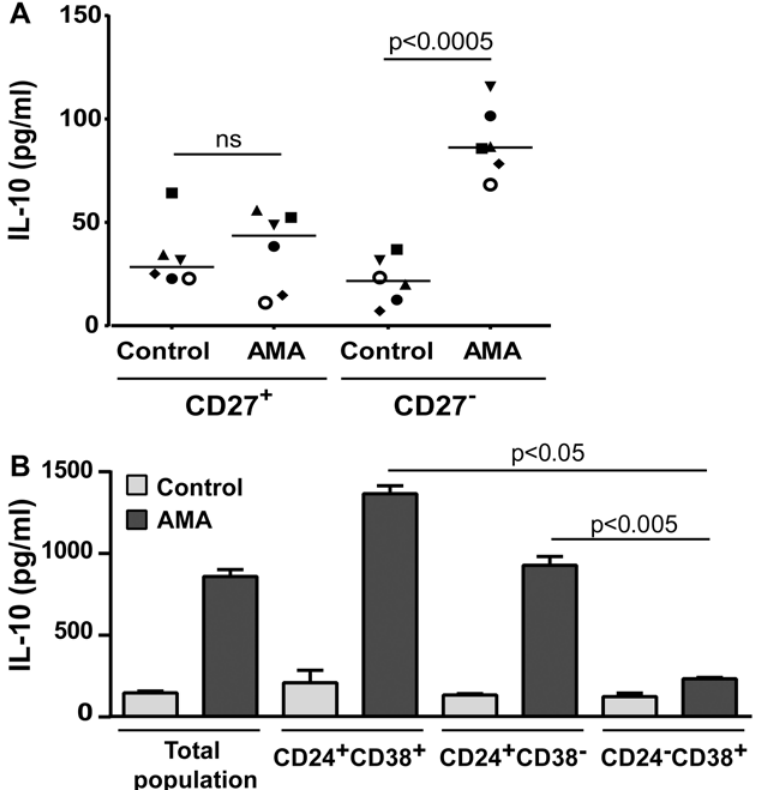
Fig 5. Characterization of the B-cell population(s) secreting IL-10 in response to parasites. A) Purified human B cells were separated in two distinct subpopulations (i.e. CD27 + and CD27 - ) and cells were incubated or not overnight with L . infantum amastigotes at a final parasite:host cell ratio of 3:1. Finally, IL-10 production was quantified by ELISA. Results are expressed as means +/- SEM and P values are calculated by two-tailed Student ’ s t-test (n = 6). B) Purified human B cells were either left unseparated or separated in three distinct subpopulations (i.e. CD24 + CD38 + , CD24 + CD38 - and CD24 - CD38 + ) by cell sorting. Next, cells were incubated or not overnight with L . infantum amastigotes at a 3:1 parasite to cell ratio. Finally, IL-10 production was quantified by ELISA. Representative results from one donor out of three are shown, results are expressed as means +/- SEM and P values are calculated by two-tailed Student ’ s t-test.